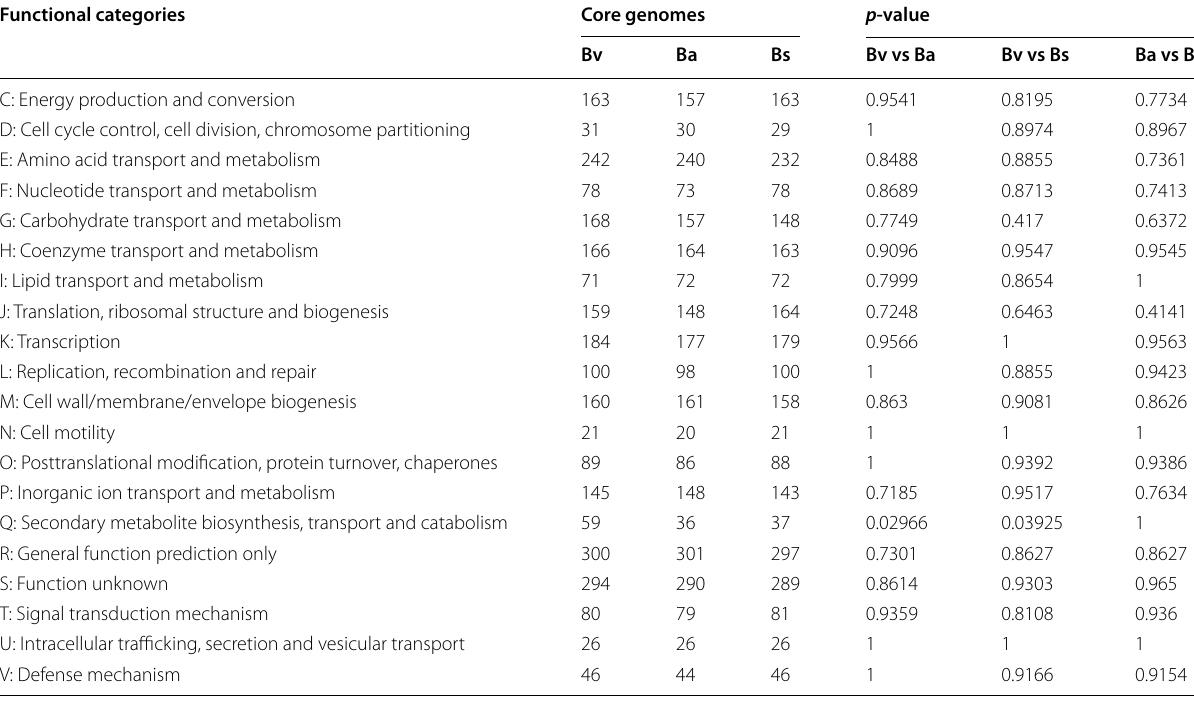
Bv, Ba and Bs represent B. velezensis , B. amyloliquefaciens and B. siamensis ,